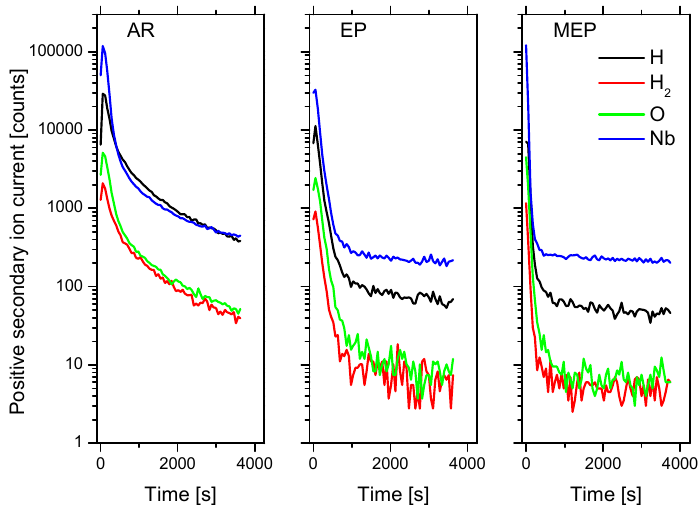
Figure 9. Primary results of SIMS depth profile analysis. Presented are values of secondary ions currents dependent on etching time using beam of 5 keV. The area of surface ion etching: 3.5 mm × 3.5 mm, the area of analysis: 1.35 mm × 1.35 mm.